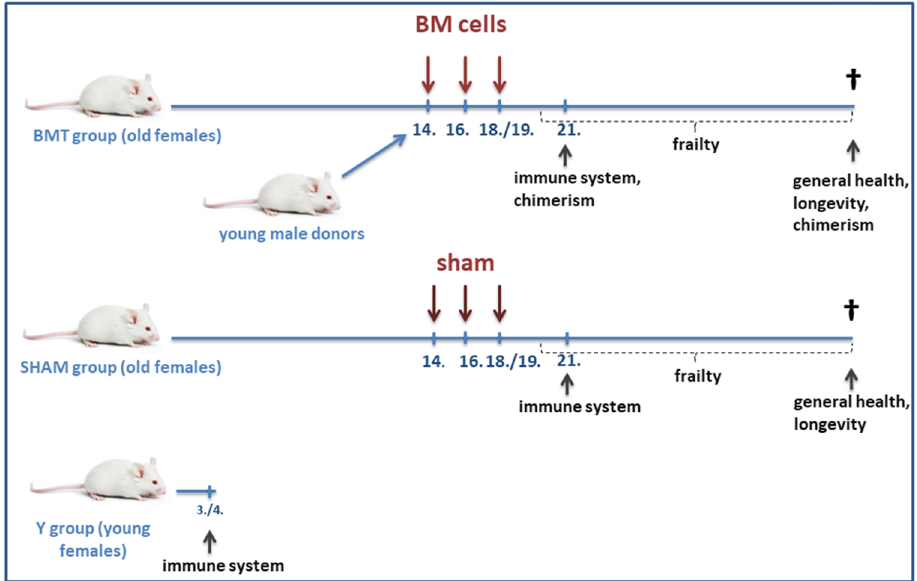
Figure 1. The experimental scheme. Numbers indicate the age of mice in months, “BM cells” indicate the time of BM transplantations, and “sham” the time of DPBS injections. Legend: BMT group— received the BMT, SHAM group—control group, and Y group—control group of young female mice.